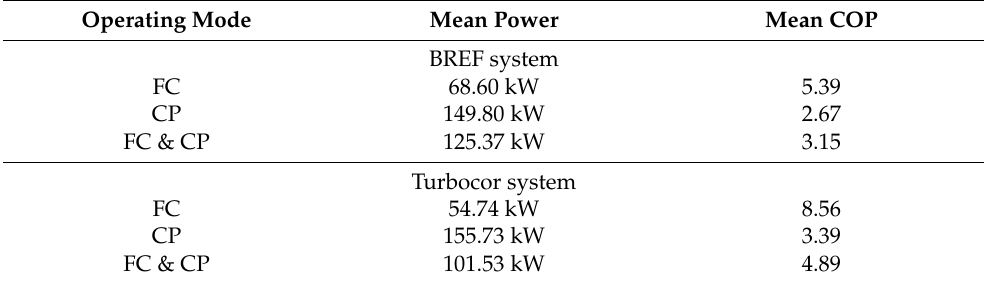
Table 9. Electric power consumption and COP parameters of the cooling systems by operating mode in year